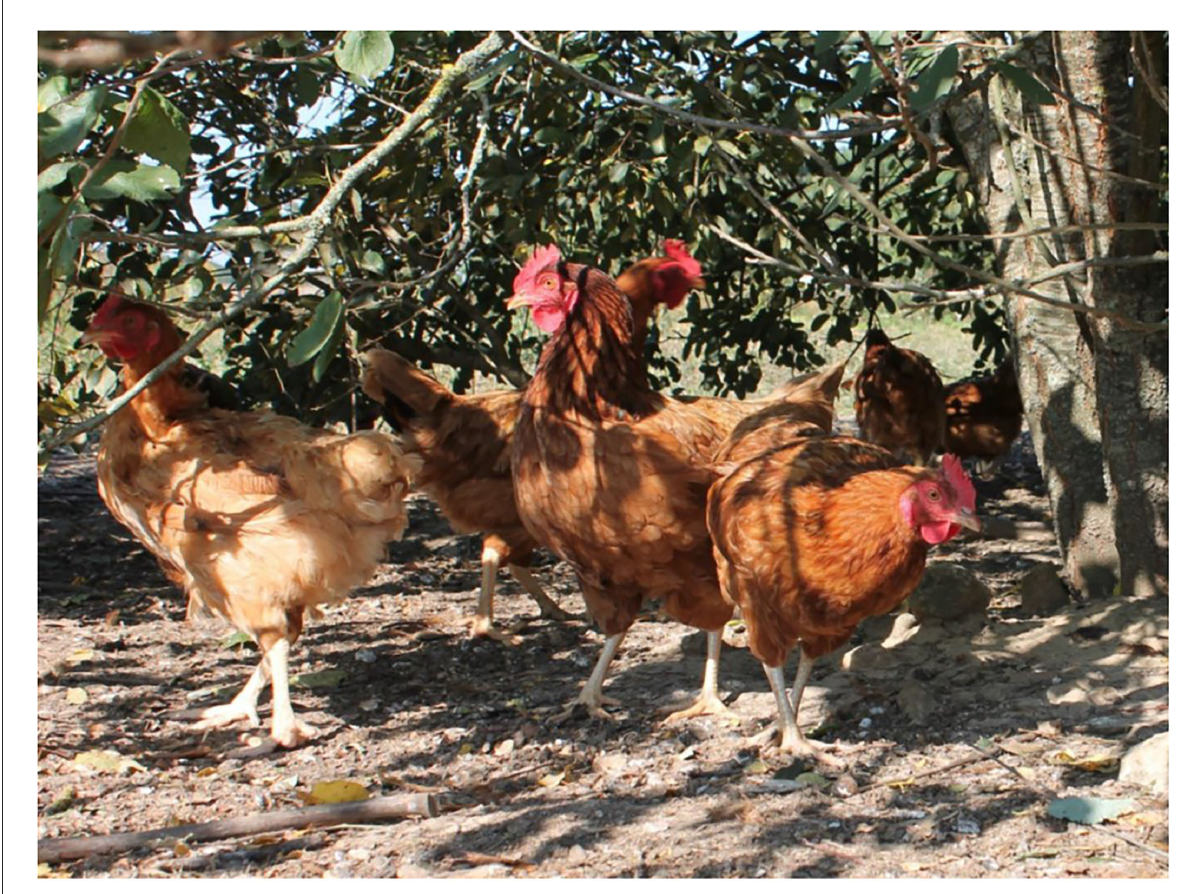
FIGURE2 Hens under bushes creating a fresh